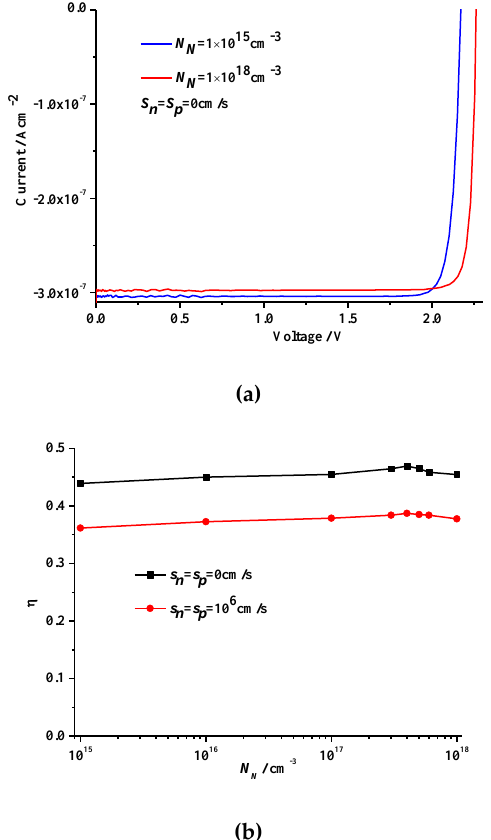
Figure 5. Output characteristics ( a ) and conversion efficiency ( b ) of the battery with different N N.